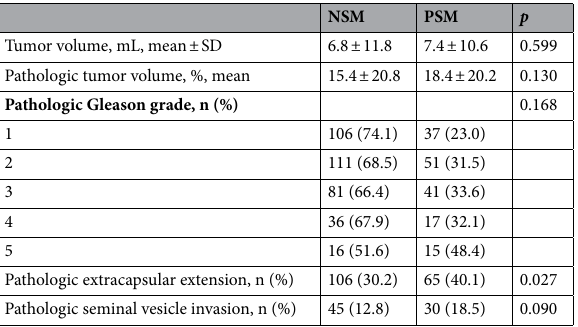
Table 2. Pathologic characteristics according to surgical margin status. NSM: negative surgical margin, PSM: positive surgical margin.